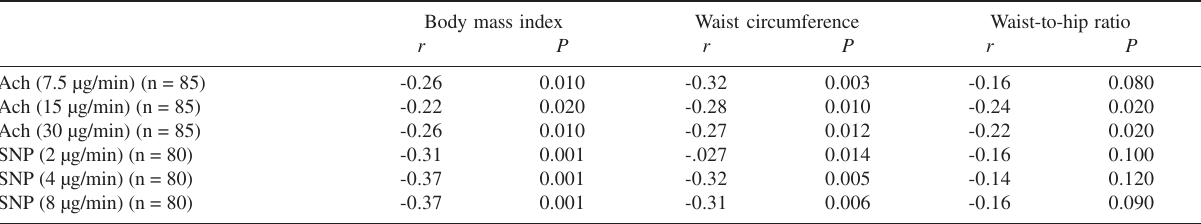
Table 2 - Correlations (Spearman r ) between forearm blood flow and obesity indexes in all patients